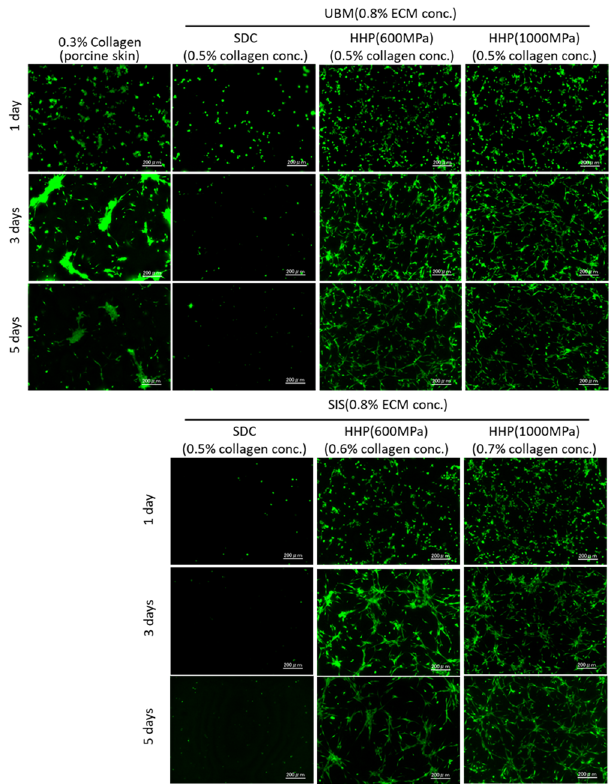
Figure 7. Cell adhesion of rat brain microvascular endothelial cells on 0.3% collagen hydrogels and d-ECM hydrogels at 0.8% d-ECM. The calculated collagen concentration in d-ECM hydrogels is shown in brackets. Green represents live cells stained by Calcein-AM. Scale bar: 200 µm. SDC and HHP represent the method of decellularization of each tissue (urinary bladder matrix (UBM) and small intestine submucosa (SIS)).